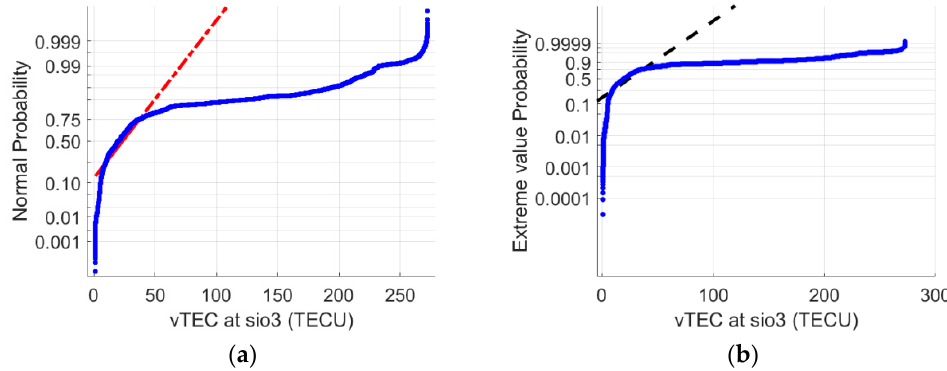
Figure 2. Probability distribution tests of TEC against the Normal (panel a ) and the Extreme Value (panel b ) distributions. The TEC data are from the SIO3 station from 30 October 2003. Red and black broken lines represent normal and extreme value distribution, respectively.